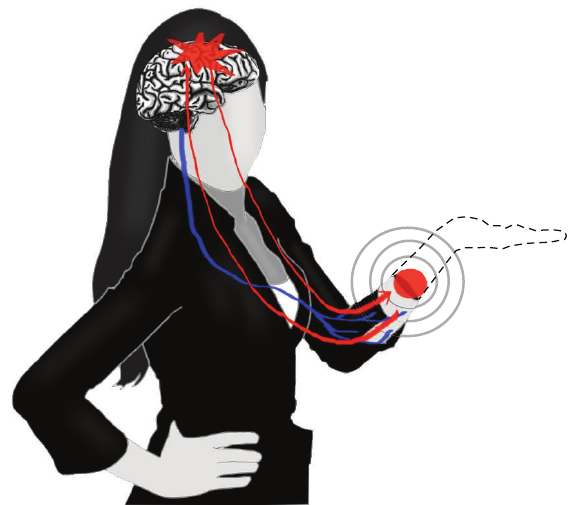
Figure 3: Phantom limb pain depiction. The nerve endings (located at the red circle), still present at the site of the amputation, send signals (red arrows) or the cortical reorganization (red star in the brain) generates the phantom limp pain [17]. Other sensations that can be felt involve tingling, cramping, heat, and